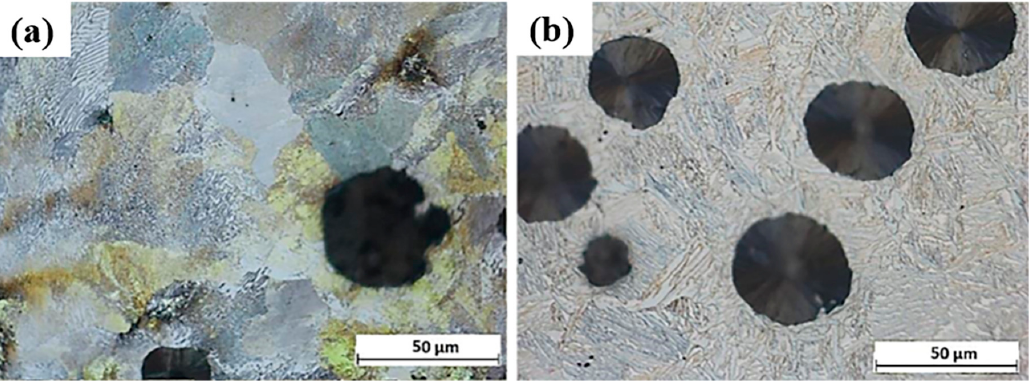
Figure 4. Optical micrograph, ( a ) DI (Perlite + Nodules + Segregations), ( b ) Austempered Ductile Iron (ADI; Ausferrite + Nodules +